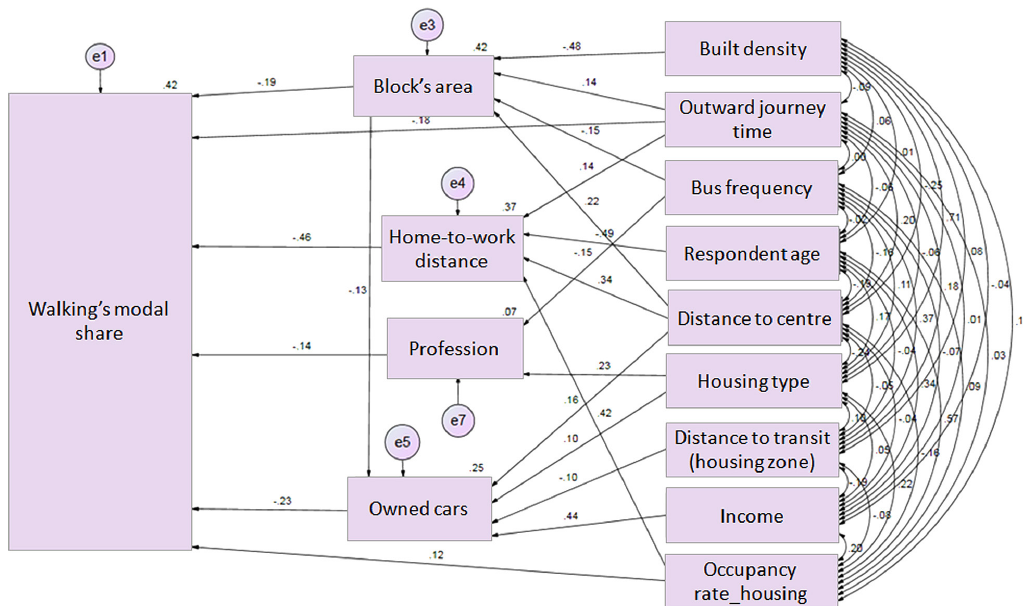
fig. 14. Path analysis of the modal share of walking.